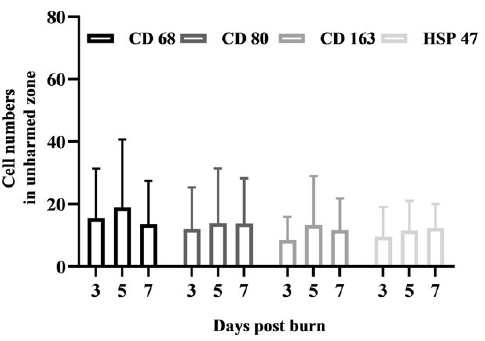
Figure 3. Number of resident macrophages and fibroblasts in undamaged subcutaneous tissue. Composite tissue samples from 6 different donors were maintained in vitro for three, five or seven days after injury. Later, tissue sections were subjected to immunohistochemistry and diaminobenzidine (DAB) staining using antibodies against CD68, CD80, CD163, and HSP47. The number of positive cells was determined in at least 5 equivalent microscopic fields in different locations within the undamaged zones of all the samples. The mean numbers of positive cells from days 3, 5, and 7 are shown, and the error bars indicate the standard deviation (SD).